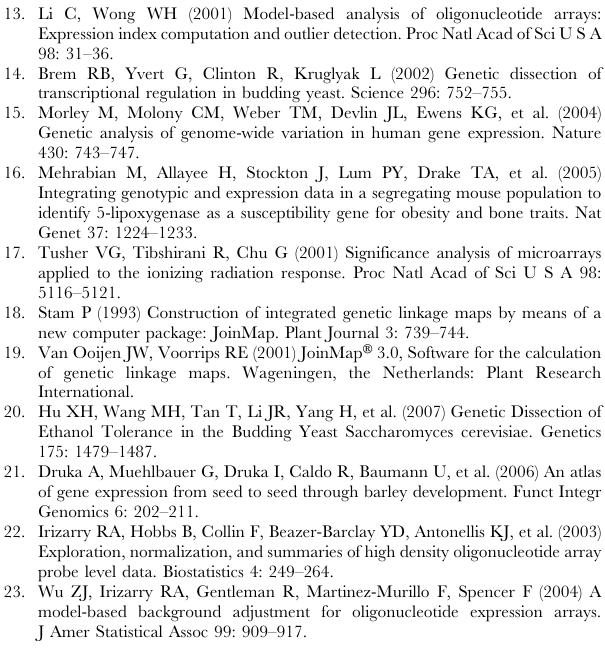
Figure S1 Genetic linkage maps of 1,378 single feature polymorphism markers identified from two barley commercial varieties (Steptoe and Morex) and their 139 double haploid offspring. Table S1 The number of SFPs called at different values of the stringency parameter delta by Method 6 (Rostoks et al 2005, Genome Biology 6,